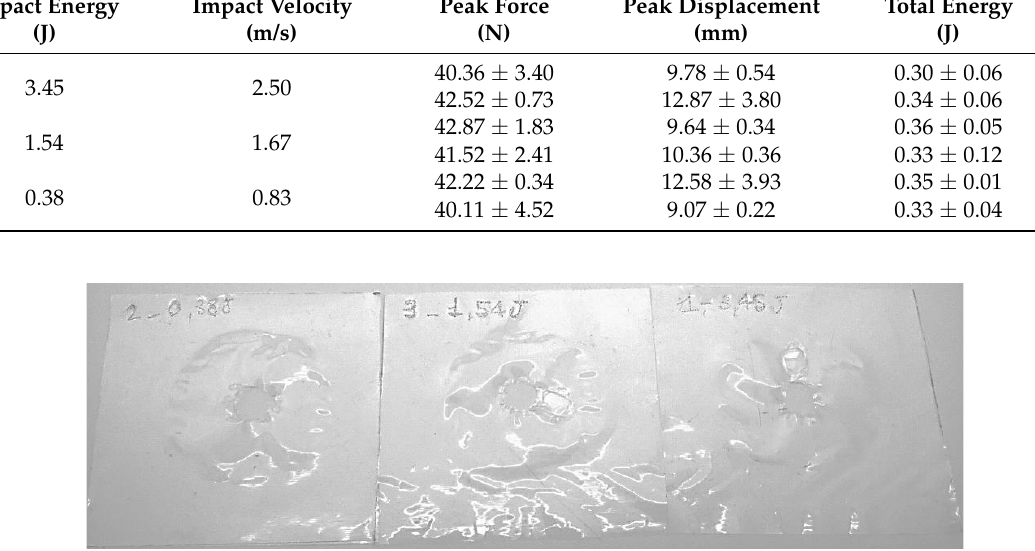
Figure 11. PFA films after the impact test: the film was perforated at all three tested impact energies.